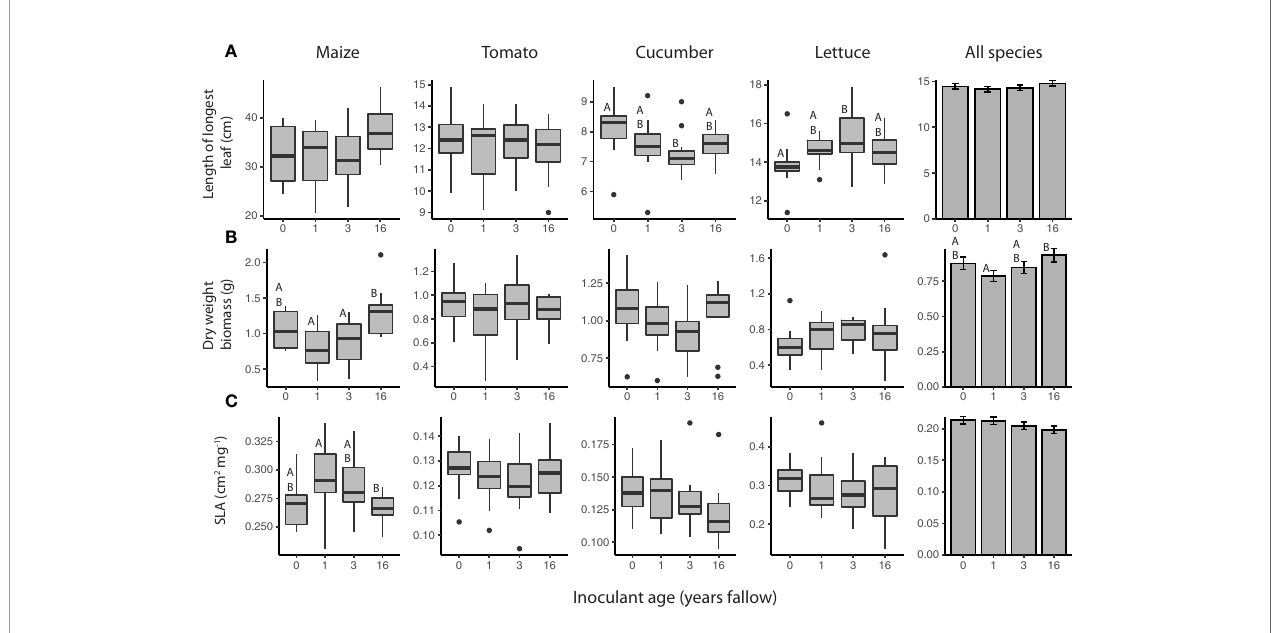
FIGURE 1 | Sizes of maize ( Z. mays ), tomato ( S. lycopersicum ), cucumber ( C. sativus ), and lettuce ( L. sativa ) plants inoculated with agricultural (0 year) or fallow microbiomes of different ages (1, 3, or 16 years post-agriculture) measured as (A) the length of the longest leaf, (B) dry weight biomass (roots and shoots), and (C) speci fi c leaf area (SLA). All plants (N = 11-12 per species × inoculant age treatment) were grown in a glasshouse common garden experiment. Note that 2 leaves had been harvested prior to the dry weight measurement for use in the herbivore resistance bioassays. Boxes enclose the middle 50% of values, with the 50 th percentile indicated by the midline and error bars spanning 1.5 times the interquartile range in both directions; values outside this range are indicated as black dots. Bar plots show estimated marginal means (± SE) averaged across species, and inoculant and greenhouse spatial blocks (see model outputs in Table 1 ). Letters above the boxes/bars indicate signi fi cant differences between inoculant age levels within plant species for the boxplots and across all species for the bar plots ( a = 0.05).